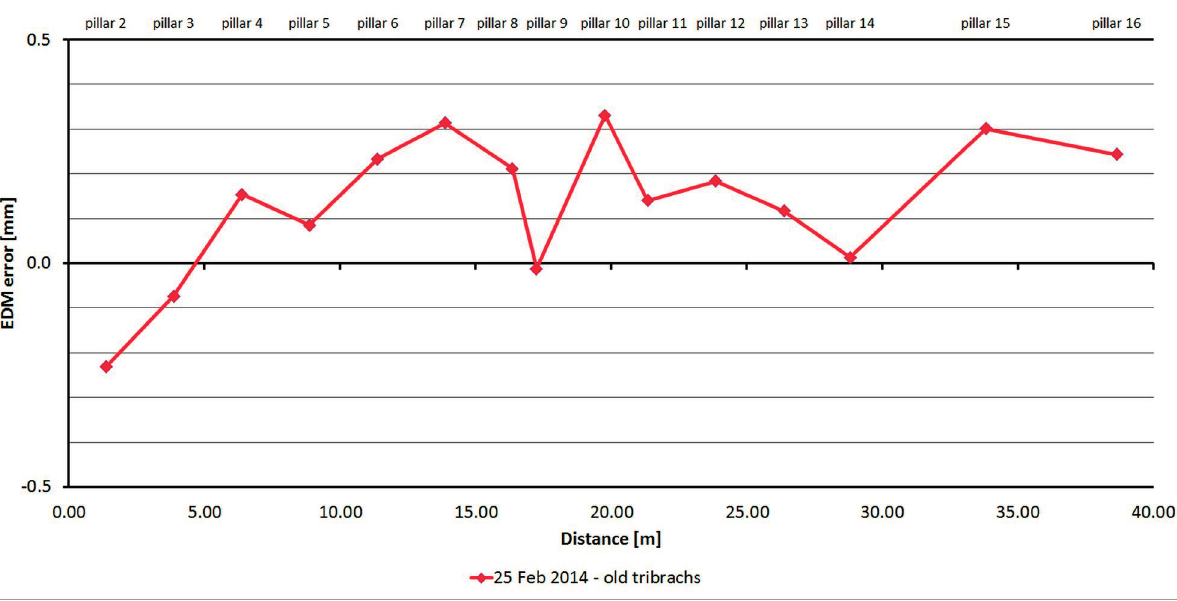
Figure 20. Leica TC1800–Absolute errors in one